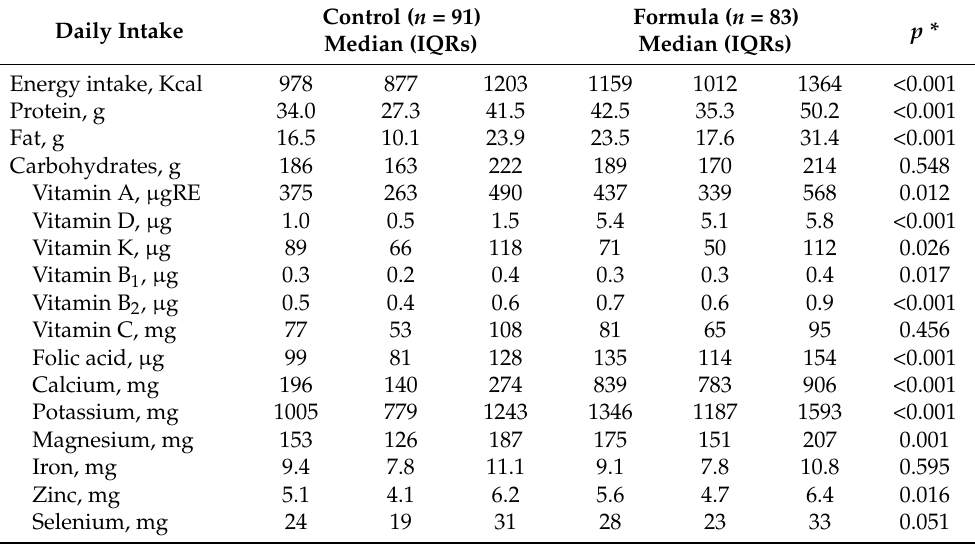
Table 3. Comparison of daily intake of nutrients in the formula and control groups during the intervention period.